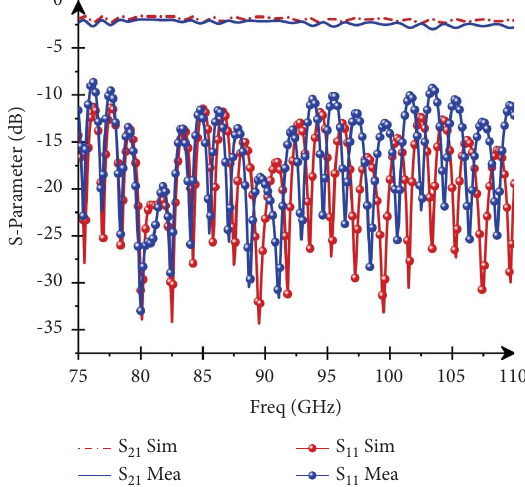
Figure 10: Te results of the refection